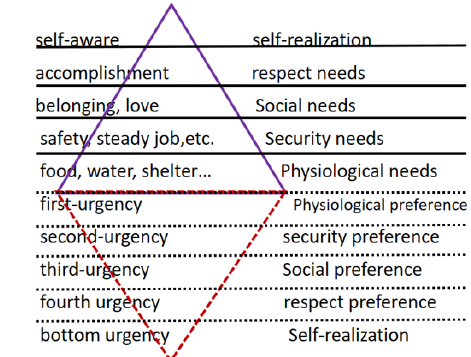
Fig. 3. Maslow’s hierarchy of needs and their mirror image for preference order (developed by the authors by using Maslow’s